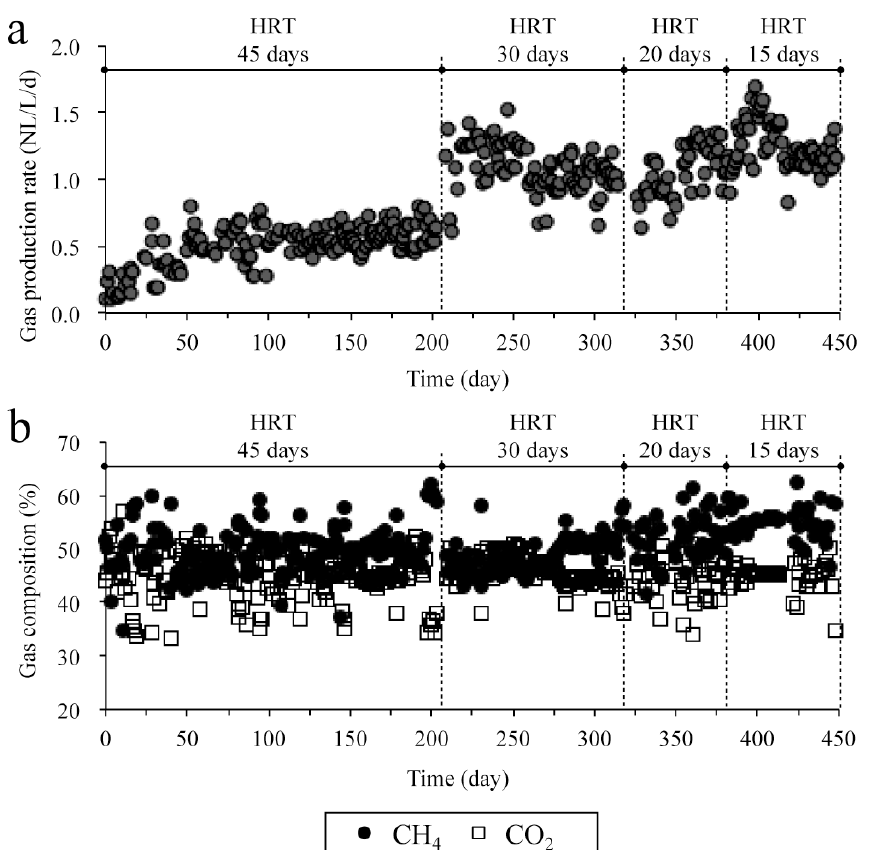
Figure 2. ( a ) Time courses of the biogas production rate; and ( b ) CH 4 and CO 2 concentrations in the biogas throughout the semi-continuous experiment. HRT: hydraulic retention